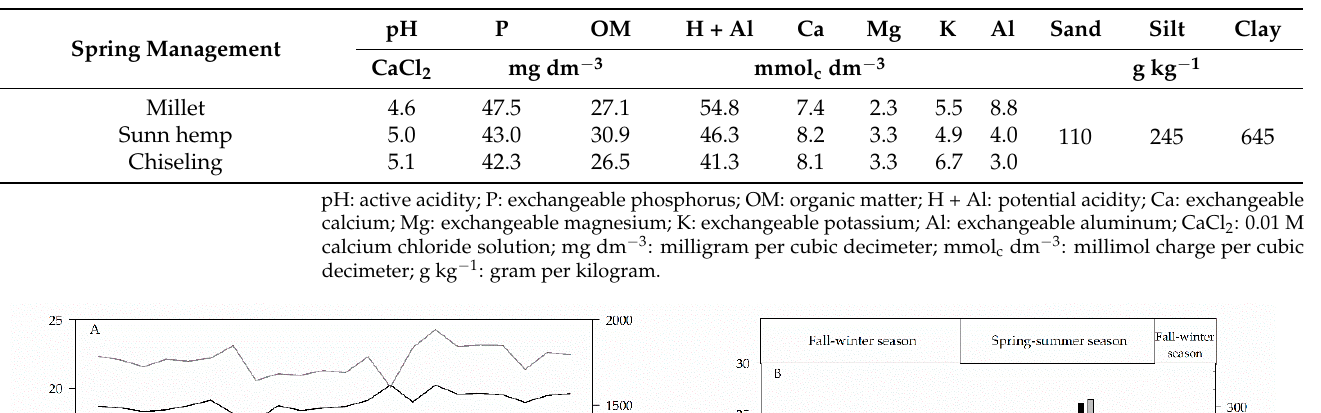
Table 2. Chemical and granulometric analysis of soil managed in long-term no-tillage, at depth 0.00–0.20 m, with crop rotation with millet, sunn hemp, and occasional chiseling.